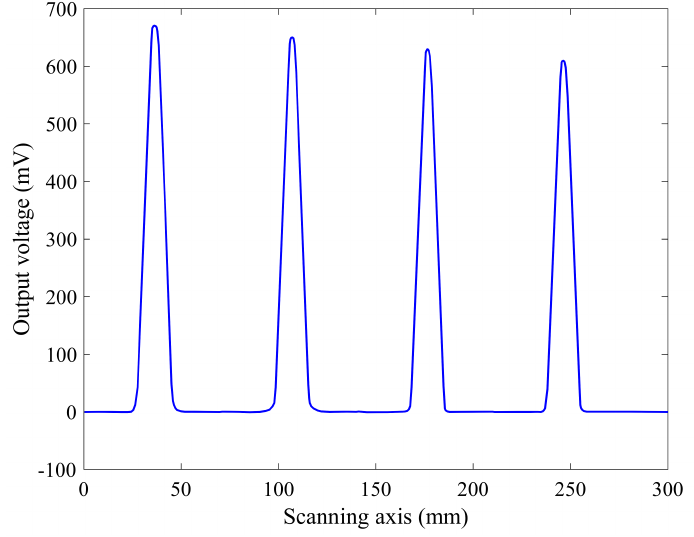
Figure 10. Experimental result showing the output voltage (mV) for various diameters of rebars placed at a depth of 10 mm. The diameter of the rebars is 5/8, 4/8, 3/8 and 5/16 inches from left to right,